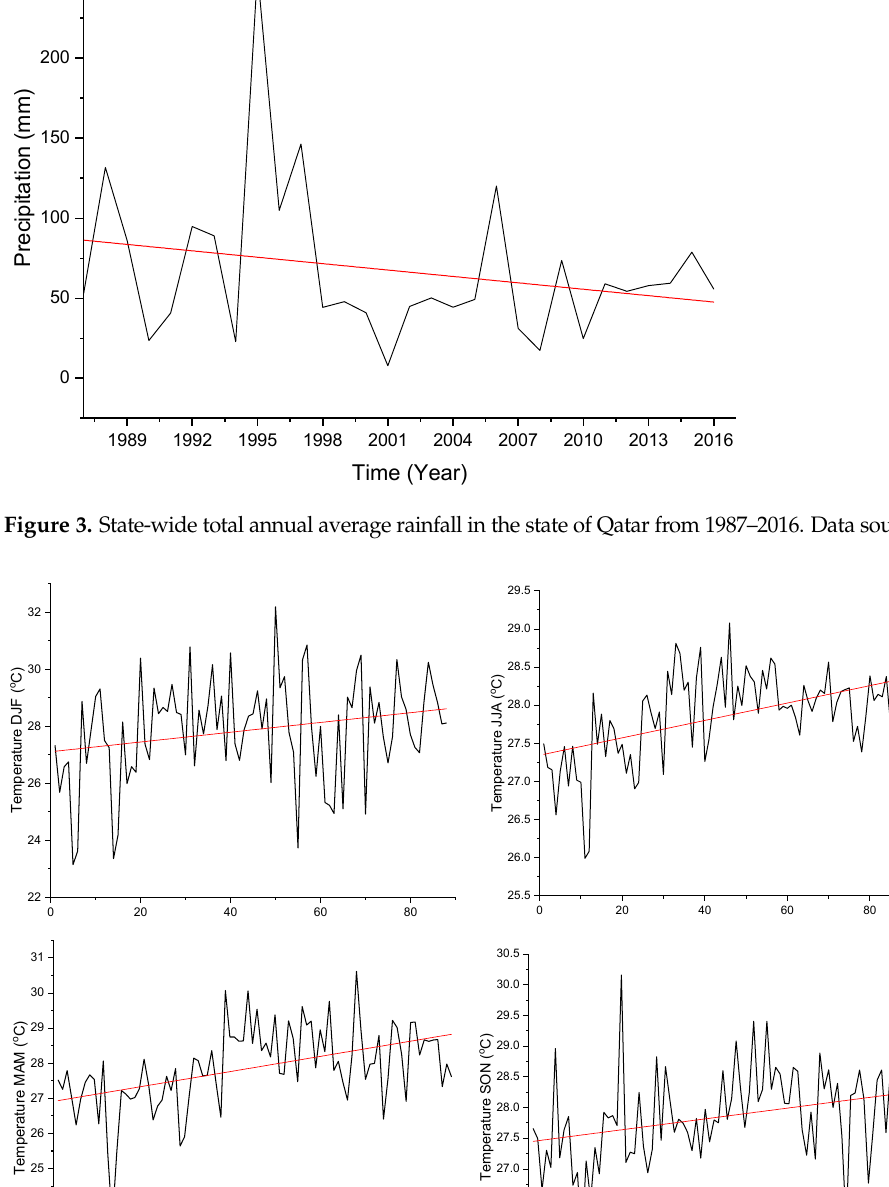
Figure 4. Monthly average seasonal temperature trends from 1987–2016. DJF = December, January February; MAM = March, April, May; JJA = June July August; SON = September, October, November. Similarly, total monthly rainfall was analysed for seasonal trends using the Mann Kendall trend test with 95% confidence. Annual rainfall in the State of Qatar is 70 mm based on the average data from 1987–2016. Most of the rainfall occurs during DJF and MAM followed by SON and JJA. JJA is usually dry with zero rainfall; however, in the recent decade, rainfall during JJA was increasing. Based on the Mann Kendall trend test, a statistically significant increment in the total monthly rainfall data was observed during JJA ( τ = 0.453, S = 0, p < 0.0001) and SON ( τ = 0.314, S = 0, p < 0.0001) (Figure 5). In contrast a nonsignificant downward trend in the total monthly rainfall was found during DJF ( τ = − 0.109, S = − 0.045, p > 0.05), while a nonsignificant increasing trend was observed for MAM ( τ = 0.047, S = 0, p > 0.05).